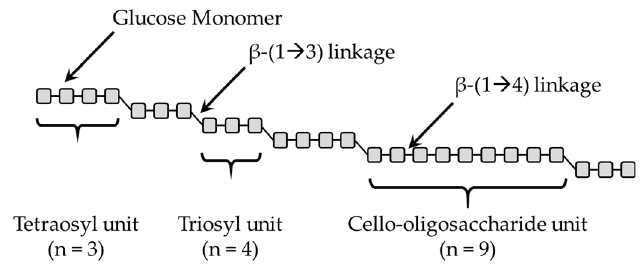
Figure 1. Cereal β -glucans structure, adapted from Tosh et al. [6].